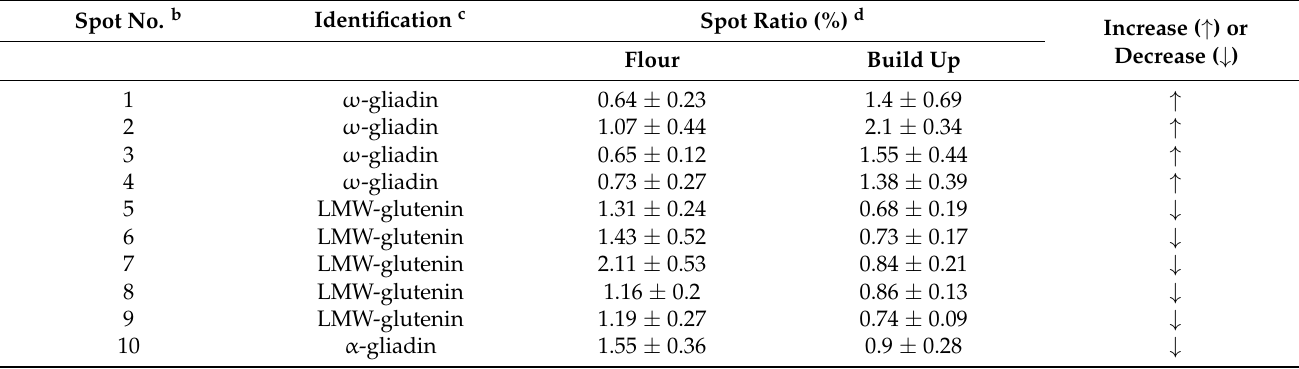
a Spots were detected by 2D-DIGE; significant differences ( p < 0.05, n = 4) among any of the groups were determined by an ANOVA test.